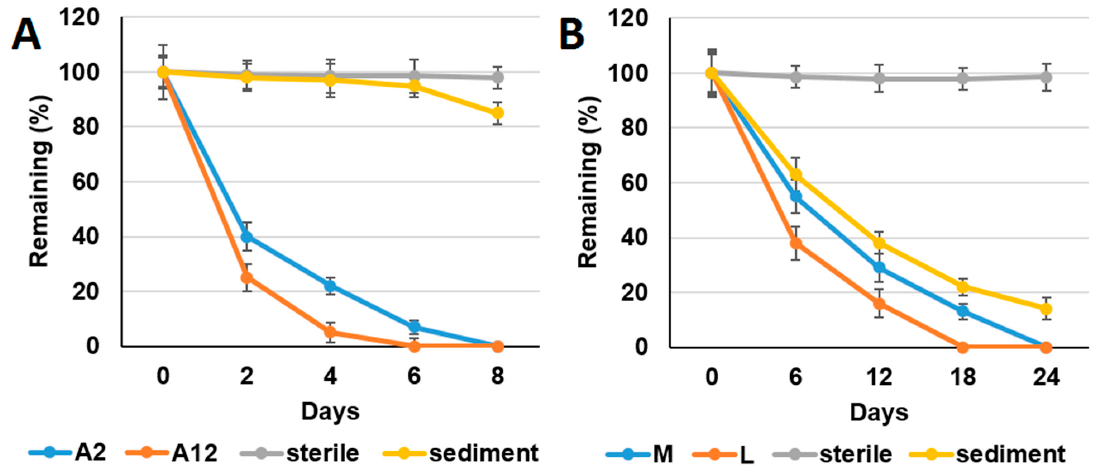
Figure 7. Biodegradation of sulfamethoxazole (SMX) by the four bacterial strains (A2, A12, L, and M) with fish pond sediments. ( A ) Aerobic SMX biodegradation by strains A2 and A12. ( B ) Anaerobic SMX biodegradation by strains L and M. Data from three independent experiments are presented as the mean ± SE.